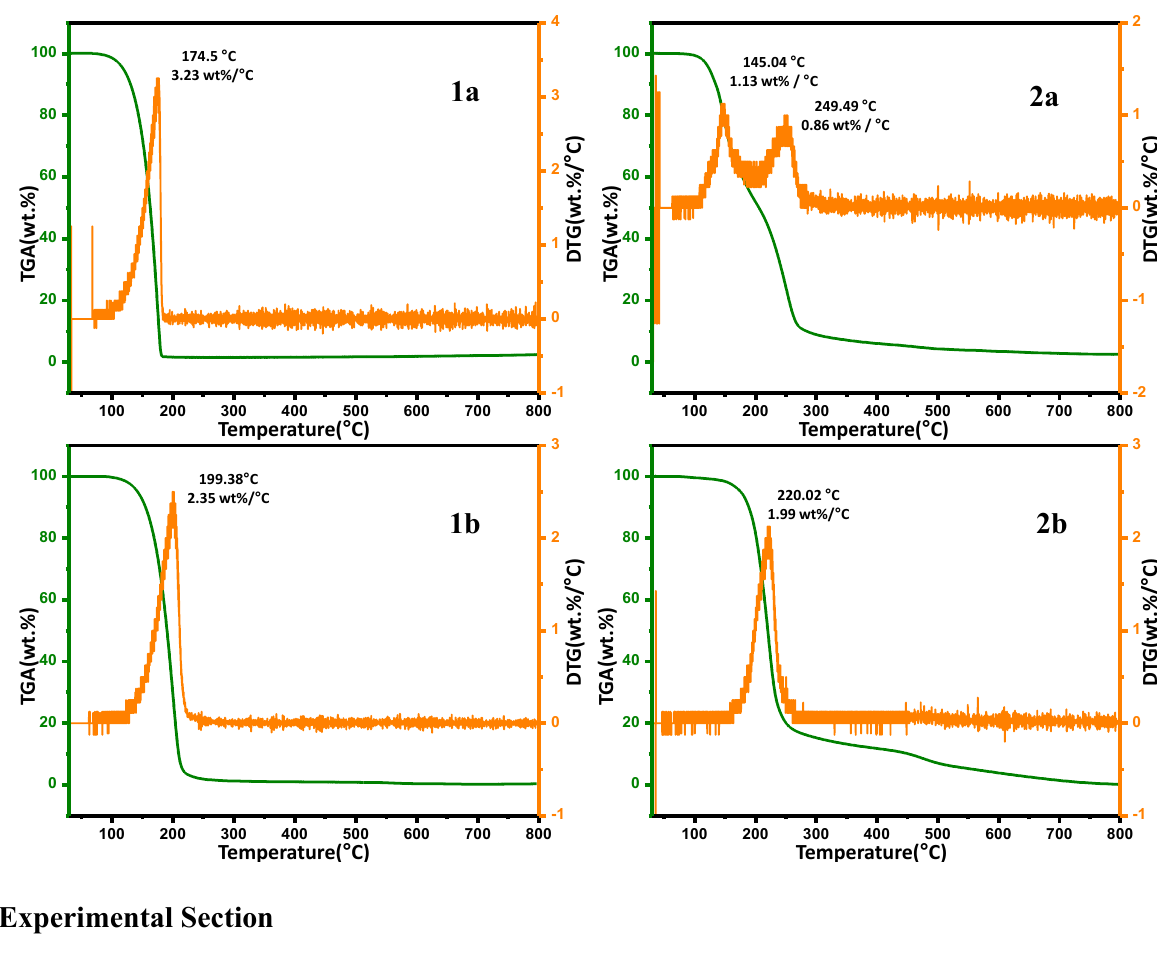
Figure 5. TGA and DTG curves of the synthesized